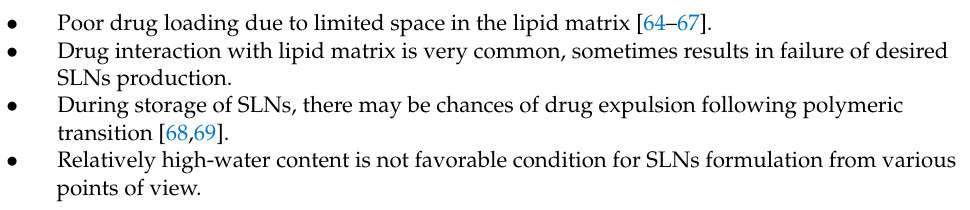
Table 2. Disadvantages of SLNs.